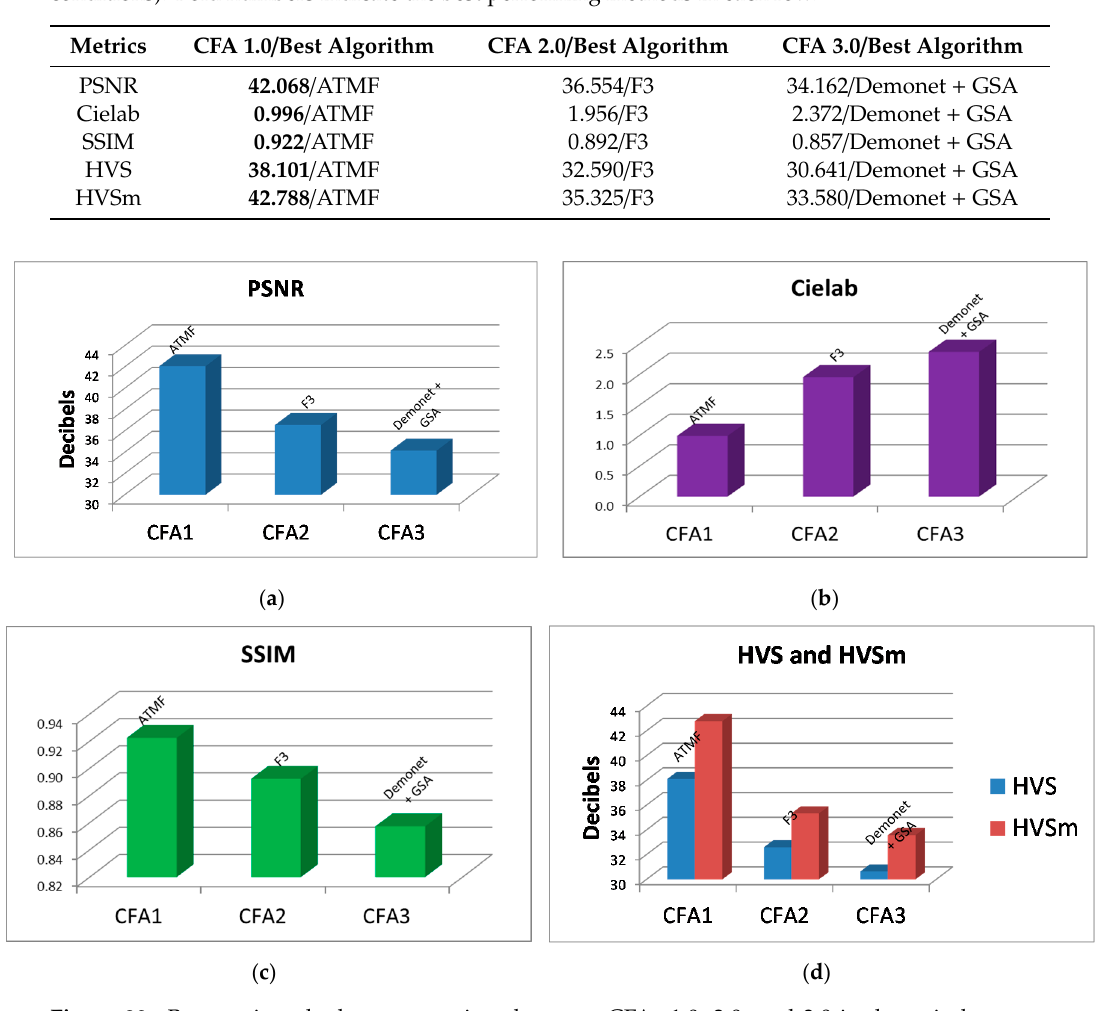
Figure 20. Best against the best comparison between CFAs 1.0, 2.0, and 3.0 in the noiseless case. ( a ) PSNR metrics; ( b ) Cielab metrics; ( c ) SSIM metrics; ( d ) HVS and HVSm metrics.